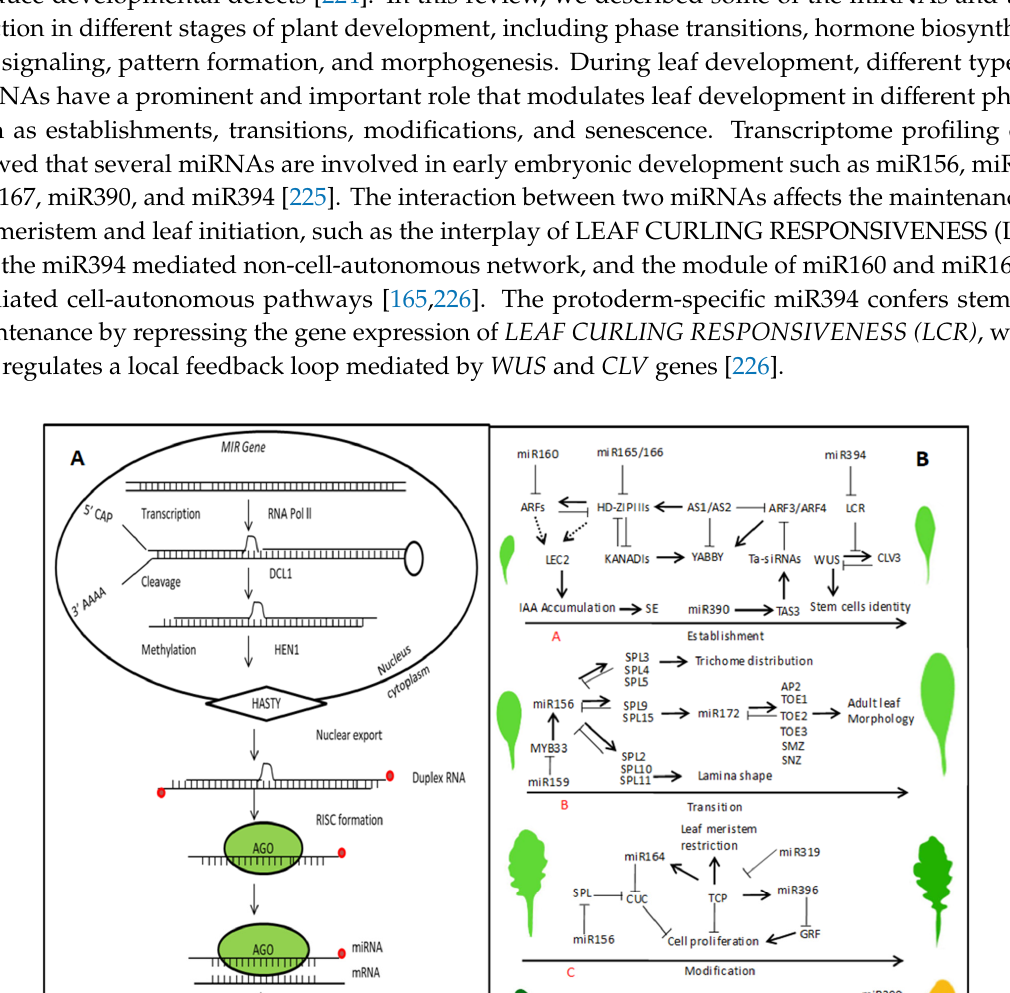
(the arrows indicate positive and T-shaped indicate negative